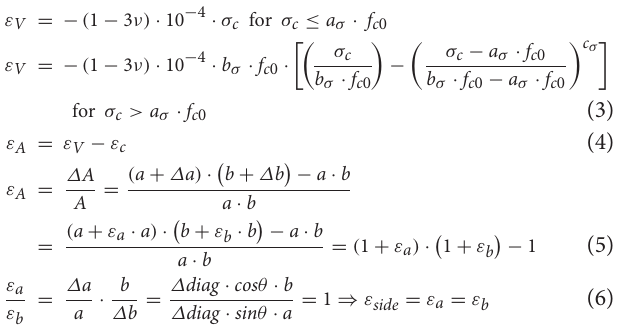
and c ε increase for higher strength concrete. Higher values of α ε are used for higher nominal strength, up to 1, whereas the post peak response becomes more brittle ( c ε tends toward or exceeds 3). The same behavior (linear and parabolic part) has also been stress ( Figure 7